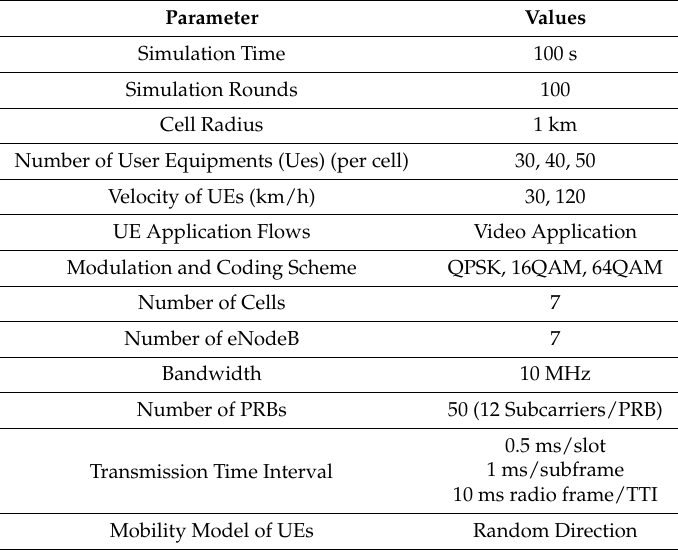
Table 1. Parameters of simulation.